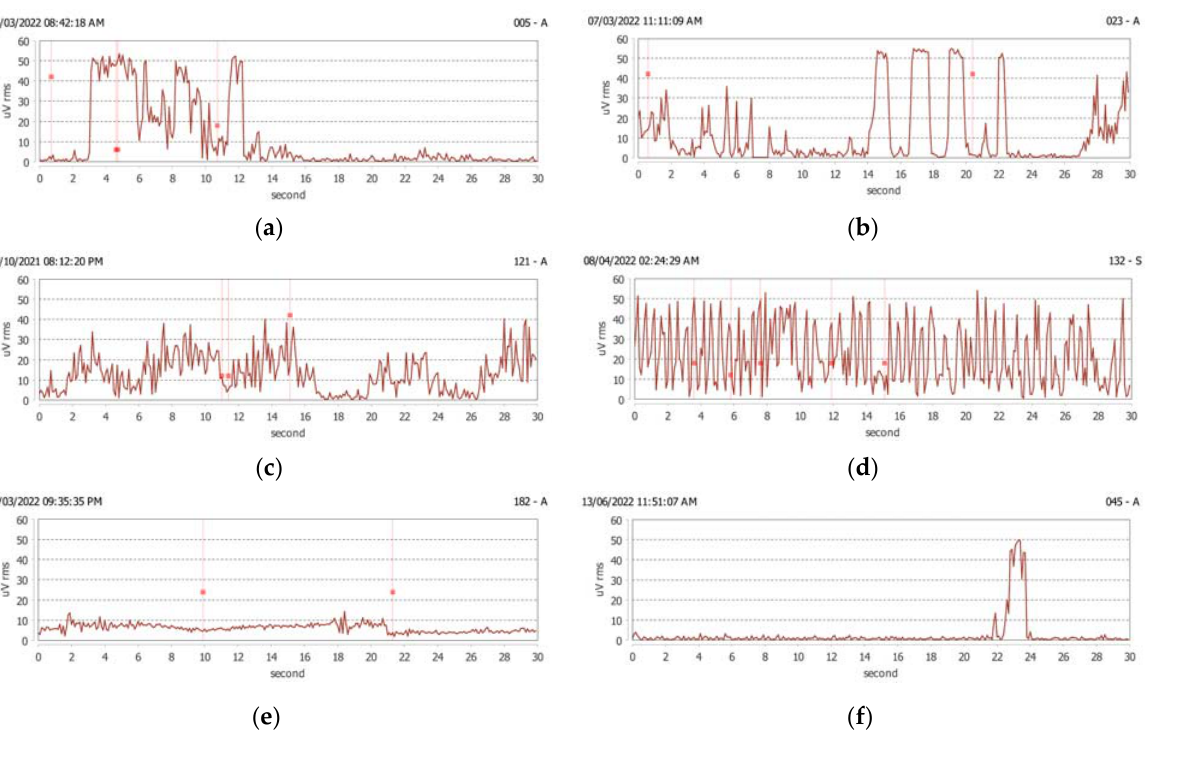
( j ) Figure 2. Comparative analysis of the summary of relevant activities recorded at the masseter level (sleep time interval—green color, awake time interval—red color, detachment time inter- val—yellow color) for: ( a , c , e , g , i ) one participant from the study group and ( b , d , f , h , j ) one partici- pant from the control group. Analyzing the data exported by the device, the following were found: the duration of the recordings varied from 15 h to 24 h, and most participants (87.5%) had recordings